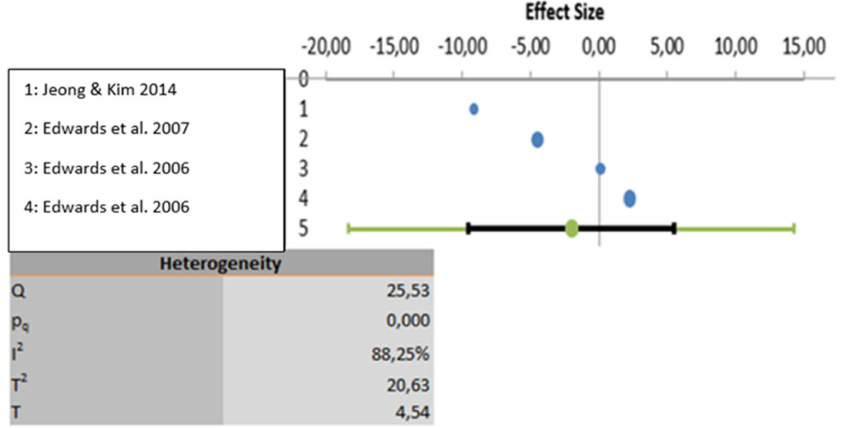
Figure 3. Data analyzed for the variable attitudes.